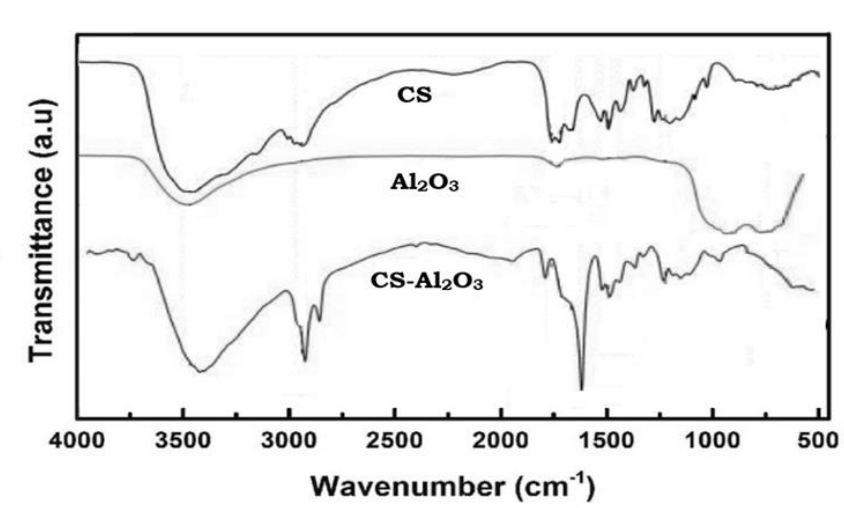
Figure 1. FTIR of chitosan (CS) and Al 2 O 3 as compared to Chitosan − Al 2 O 3